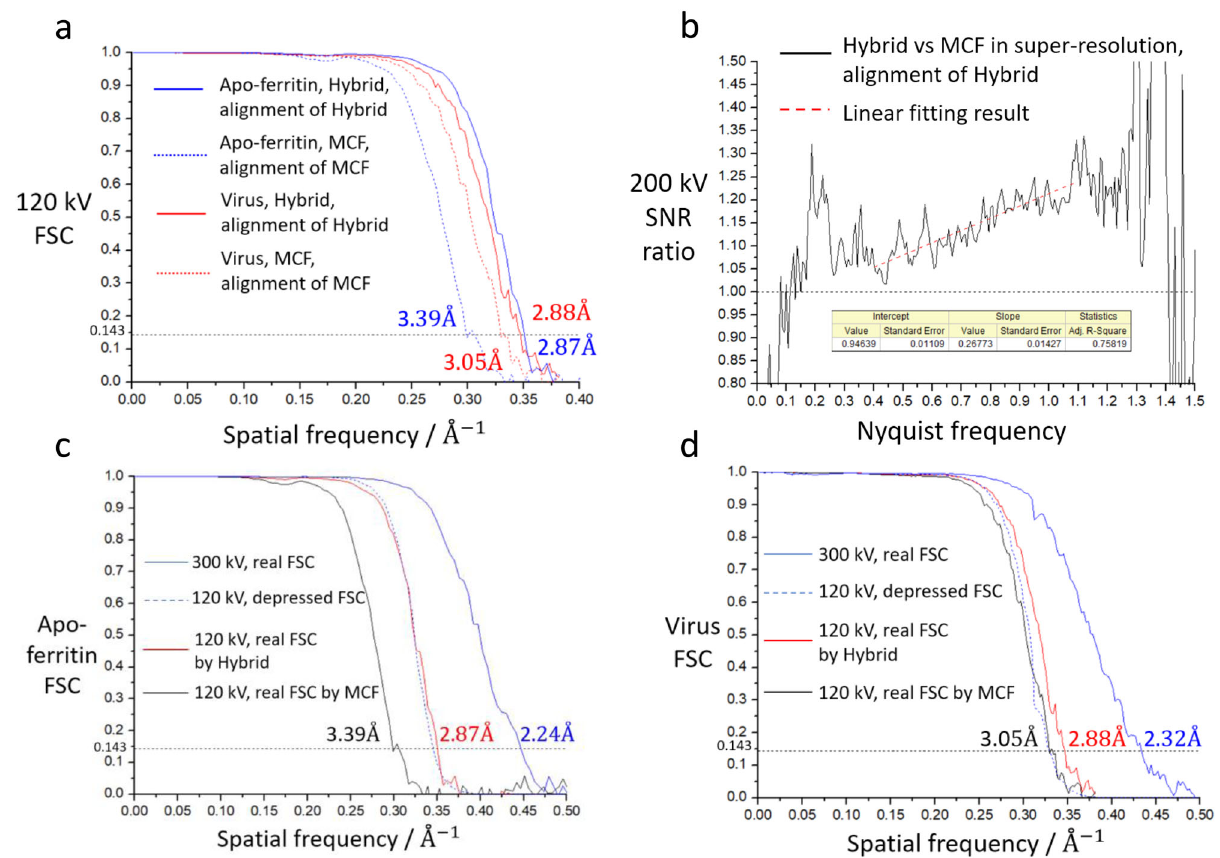
Fig. 4 Performances of Hybrid algorithm and low-voltage cryo-EM. a FSC curves of apo-ferritin and Coxsackievirus A10 dataset at 120 kV with Hybrid and MCF counting method. b SNR ratio between Hybrid and MCF at 200 kV, both in super-resolution mode. The linear fi tting interval is 0.40~1.10 Nyquist frequency. c Predicted depressed FSC and reality FSC curves of apo-ferritin. Depressed FSC is calculated by Eqs. 4 to 6. d Predicted depressed FSC and reality FSC curves of Coxsackievirus A10. Depressed FSC is calculated by Eqs. 4 to 6. All the resolution of reconstructions based on gold-standard FSC criterion marks on the